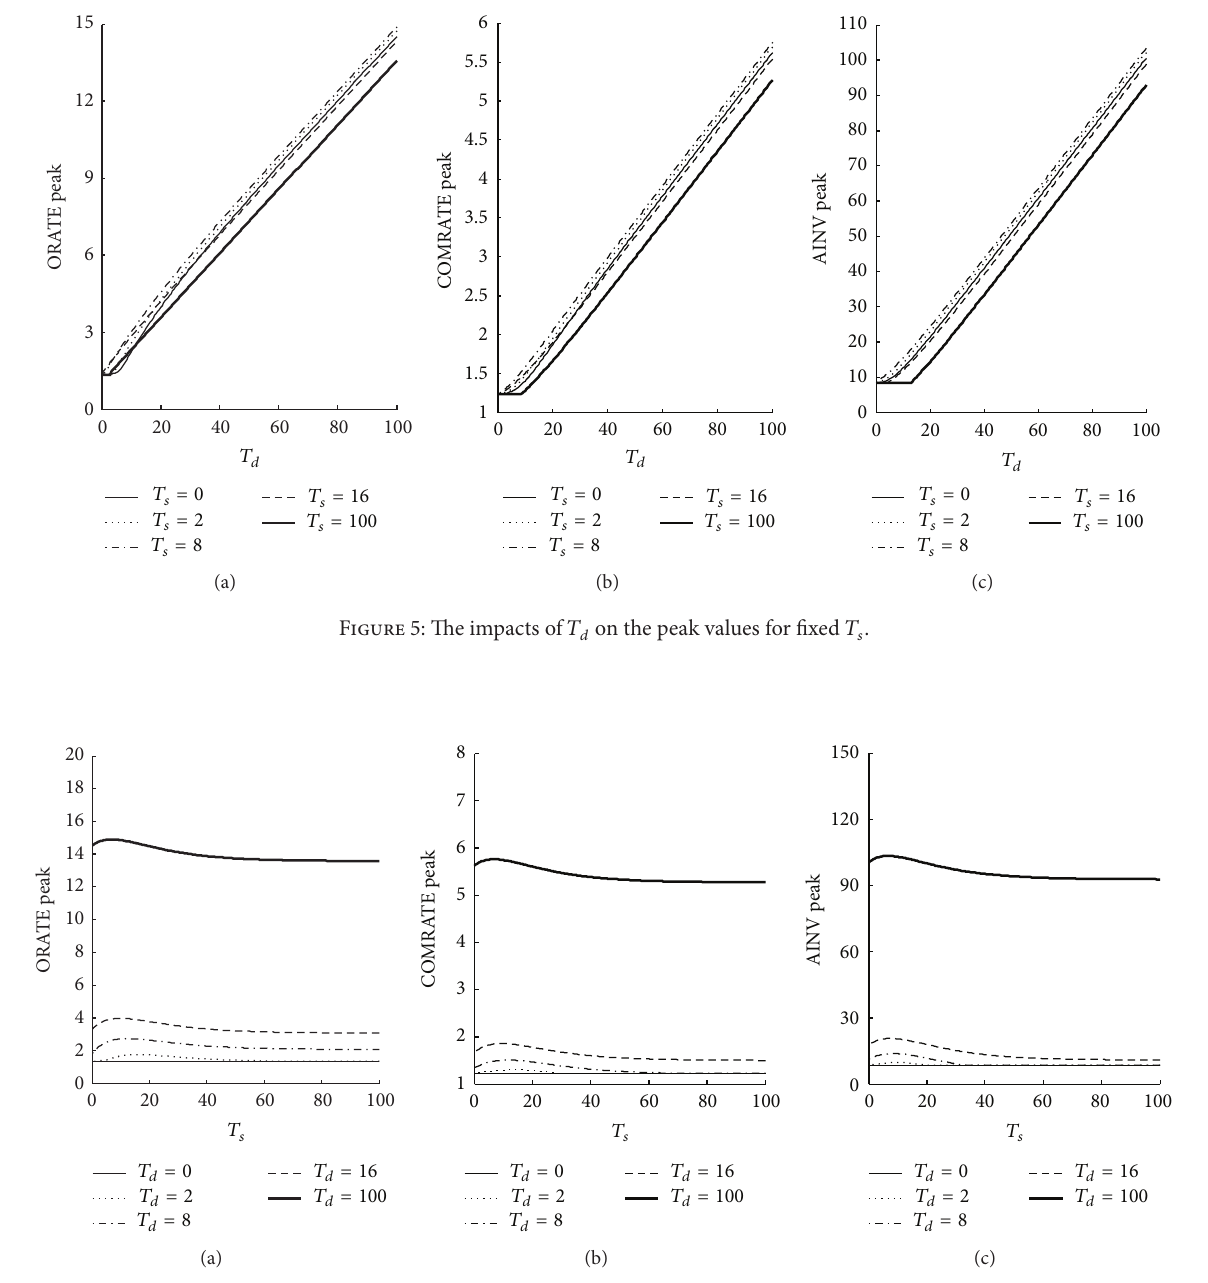
Figure 6: The impacts of 𝑇 𝑠 on the peak values for fixed 𝑇 𝑑